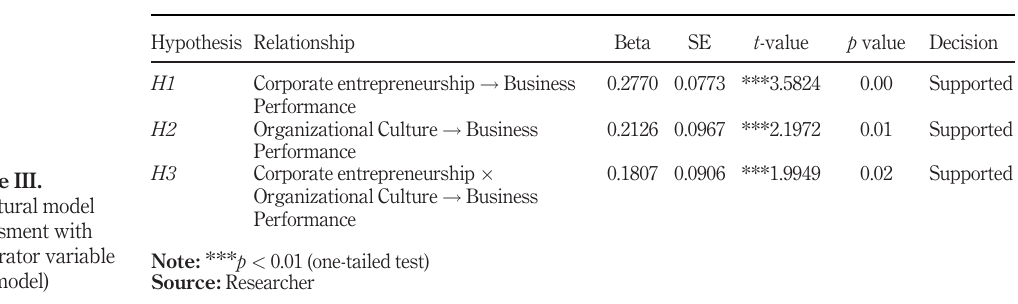
assessment with moderator variable